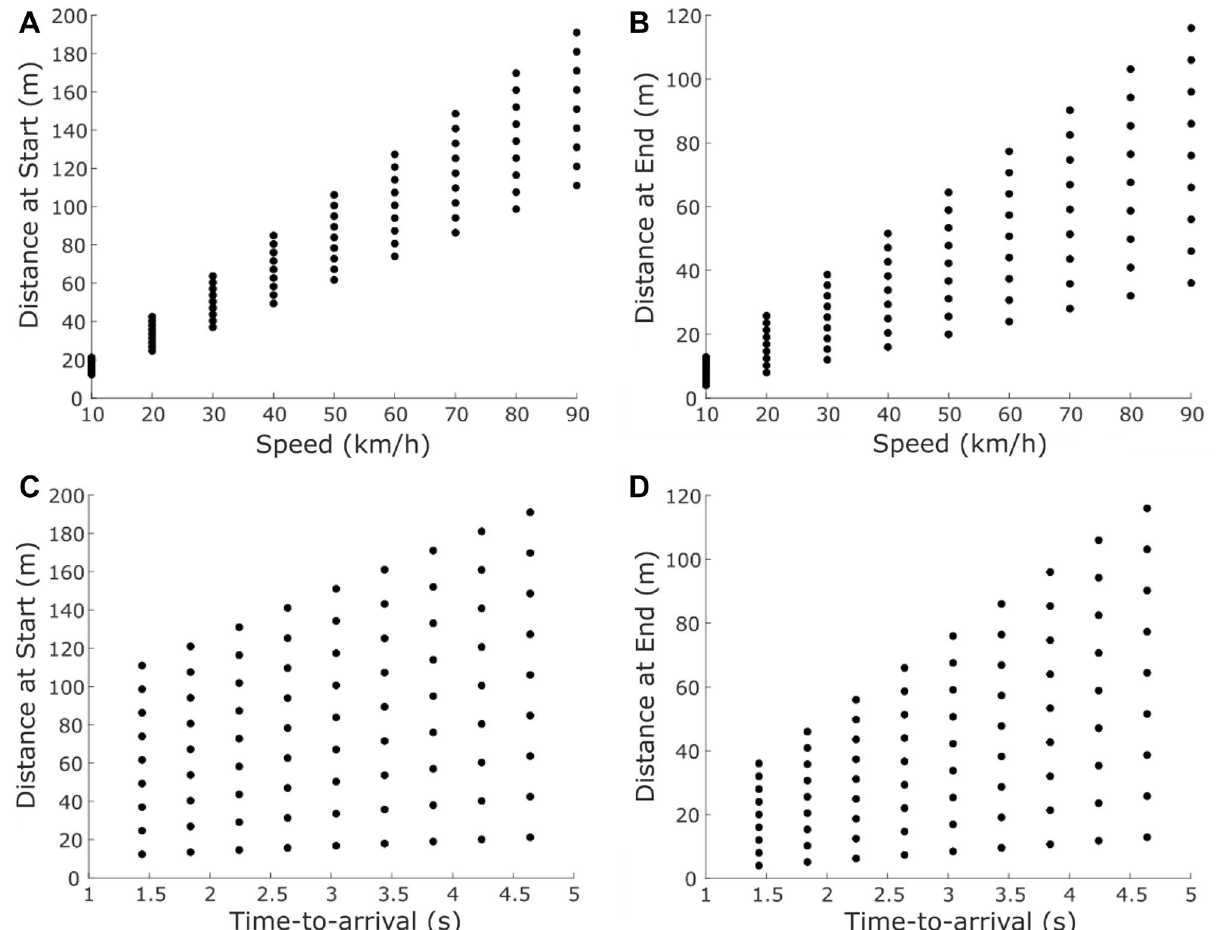
Figure 2. Distribution of the start and end position of the vehicle across speed and time-to-arrival levels. Start and end position were measured as the distance between the front edge of the vehicle and the stopping line in the virtual world in meters (m). Upper panels show the association between vehicle speed, start distance ( A ) and end distance ( B ). Lower panels show the association between the time-to-arrival, start distance ( C ) and end distance ( D